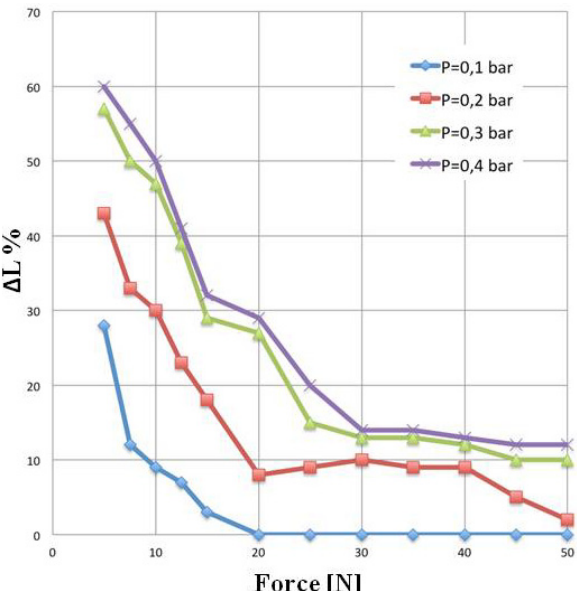
Figure 15. Force-% elongation tests on a worm muscle.